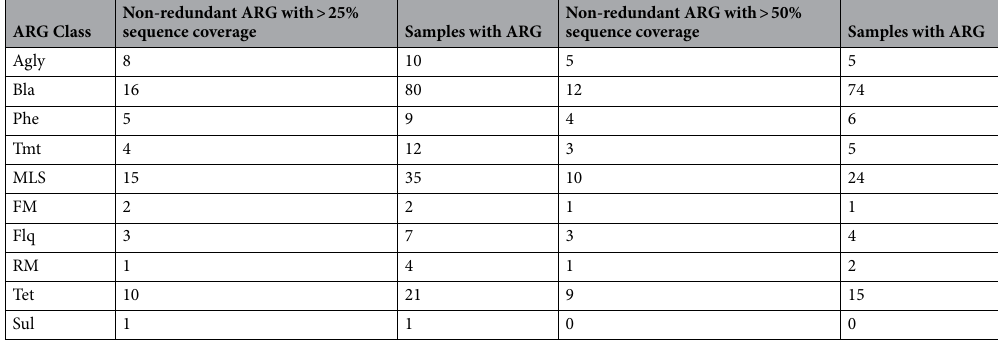
Table 4. Occurrence of non-redundant ARG sequences in COVID-19 cohorts. n = 101; Antimicrobial resistances encoded by ARG: Agly, aminoglycoside; Bla, β-lactam; Flq, fluoroquinolone; FM, fosfomycin; Phe, phenicol; Tet, tetracycline, RM, rifamycin; Tmt, trimethoprim; Sul, sulphonamide; MLS, macrolide-